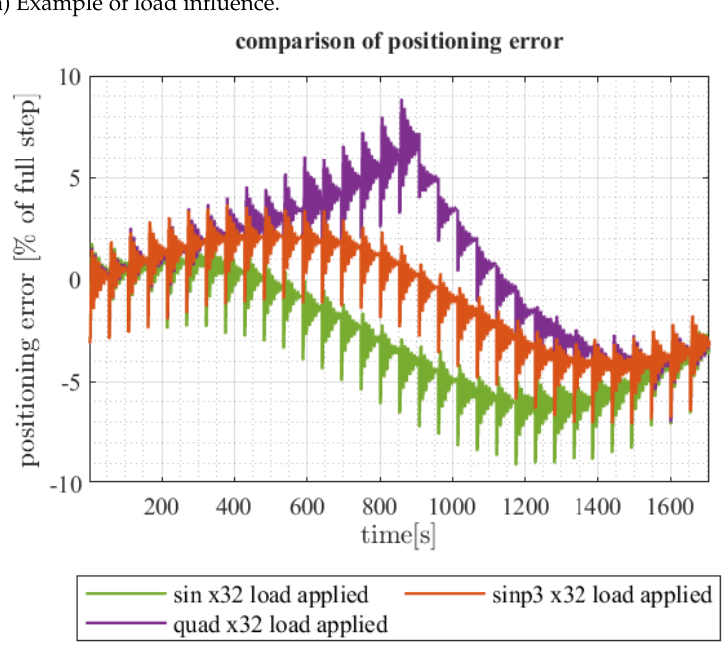
Figure 25. Influence of load and signal shape on shaft position error over one full